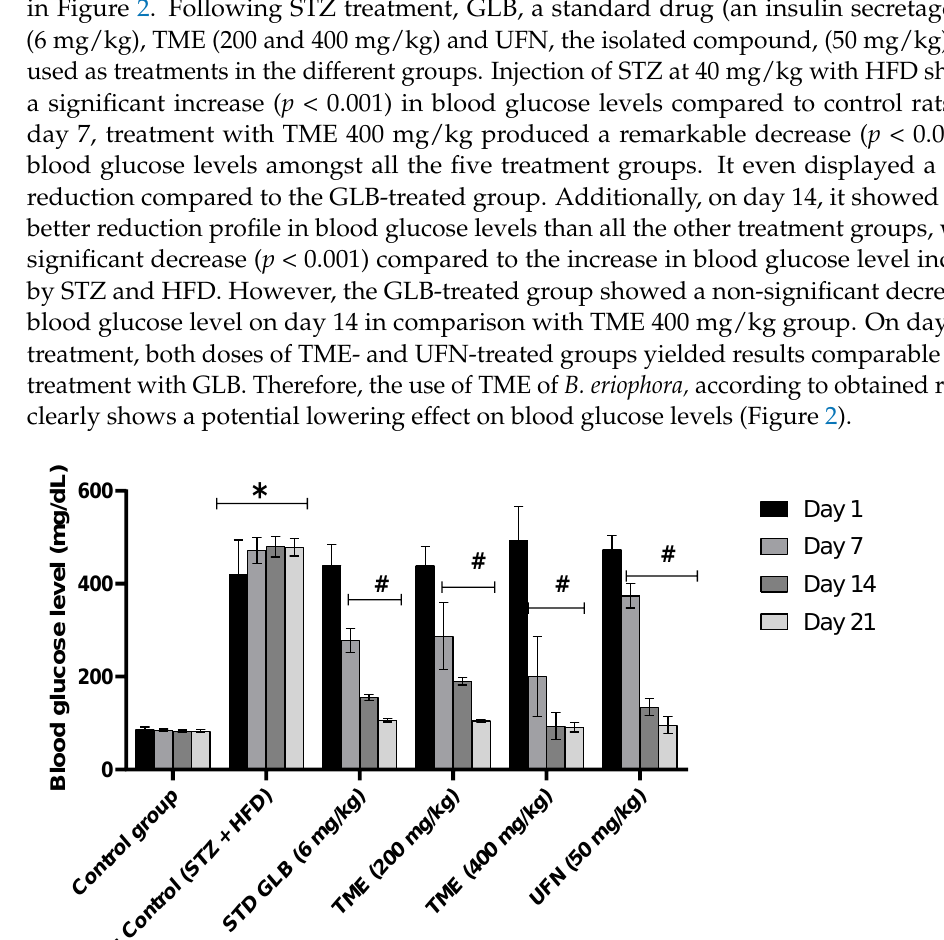
Figure 1. Structure of pure isolated umbelliferone (UFN).